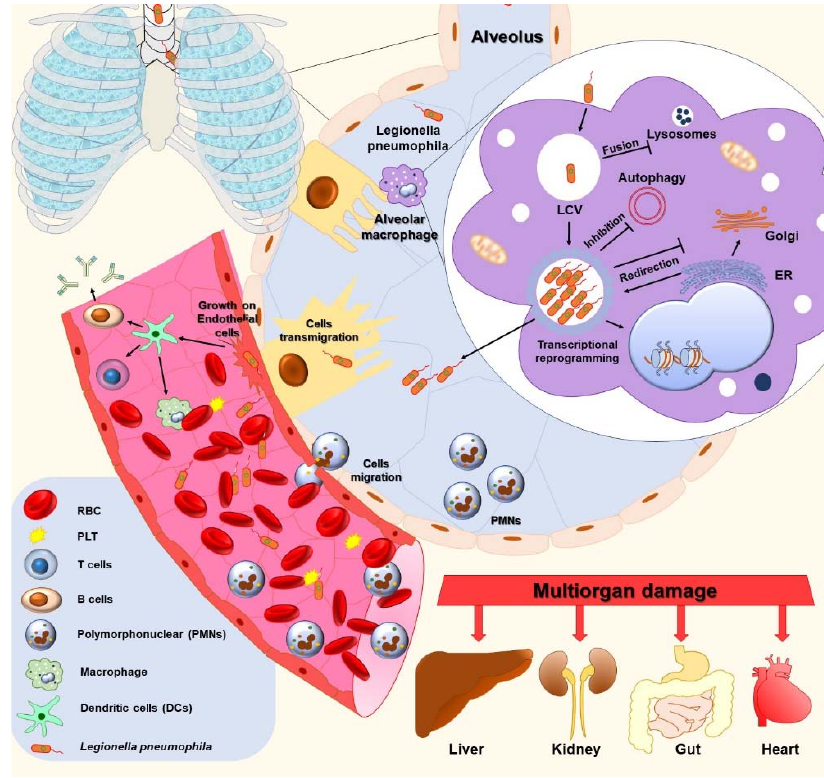
Figure 2. The host cell– Legionella spp. interaction and the pathogenesis of LD. Initially, the bacteria adhere to the host cell and are consequently up-taken via phagocytosis, ending within a vacuole (Legionella-containing vacuole (LCV)). Unlike phagosomes, the LCV recruits and redirects different proteins and energy in this specialized vacuole from its own endoplasmic reticulum (ER) and mitochondria. Subsequently, the intracellular replication of Legionella spp. is advanced. Second, small GTPase RAB1 secreted into the LCV membrane through the T4SS system results in the redirection of vesicular transport between the ER and the Golgi system. In addition, L. pneumophila disposes autophagy inhibitory mechanisms via effector proteins. Finally, bacteria are released into the cytosol and out of the macrophages. Furthermore, L. pneumophila binds via Mip protein to the collagen, which allows bacterial transmigration to the blood. L. pneumophila induces DCs maturation, which increases secretion of proinflammatory cytokines (IFN γ , TNF ‐α , IL ‐ 6, and IL ‐ 1 β ), which restricts the growth of intracellular Legionella and activates B cells.